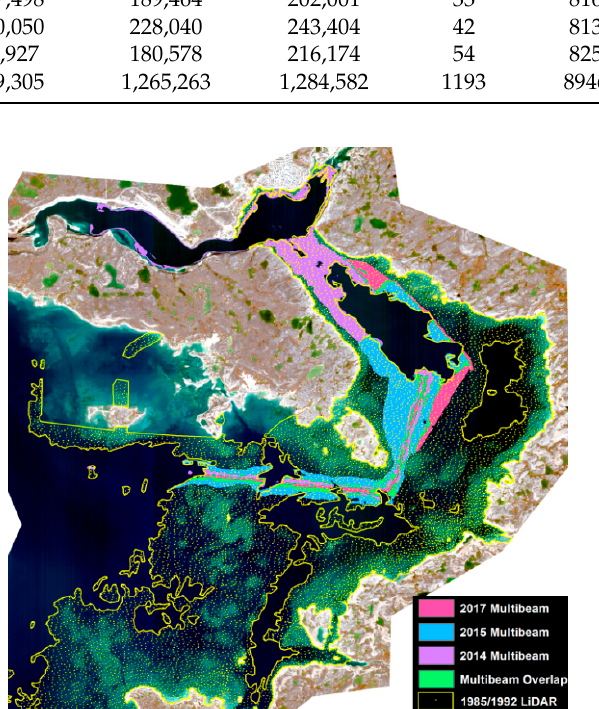
Figure 3. Spatial distribution of survey data up to 20 m in depth within Cambridge Bay. Note the wide coverage of the LiDAR survey relative to the multibeam datasets. Imagery © 2015, DigitalGlobe, Inc.